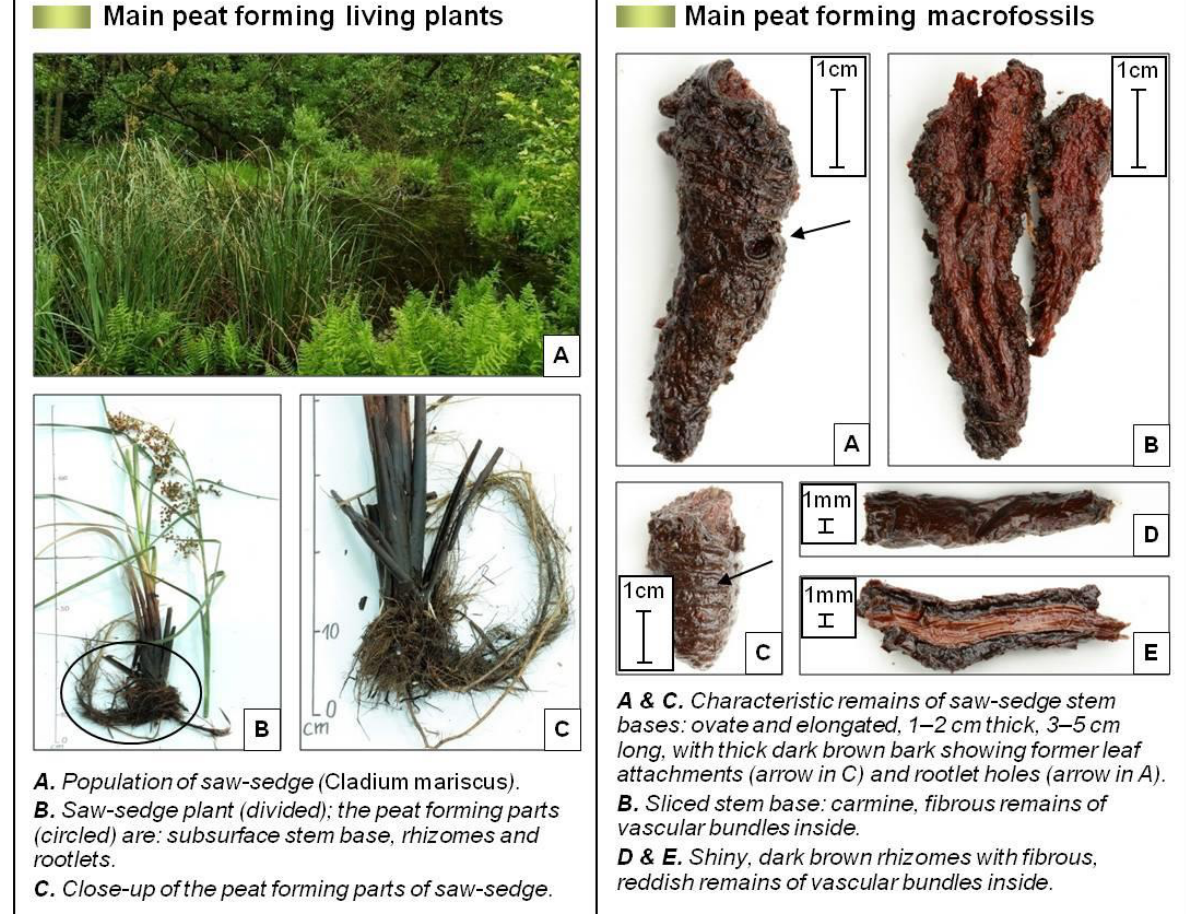
Figure 3. Excerpt from the portrait of Cladium peat, after Meier-Uhlherr et al. (2011) (page 4), translated from